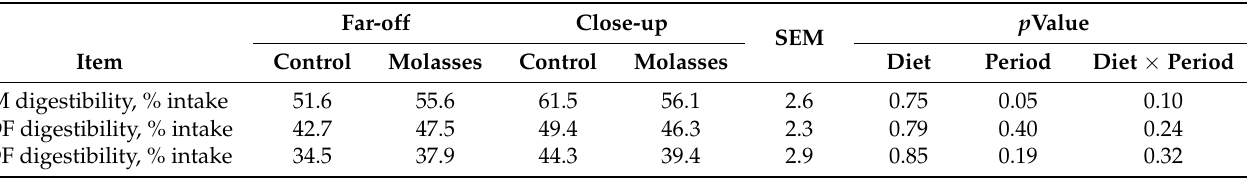
Table 10. Diet organic matter (OM), neutral detergent fiber (NDF), and acid detergent fiber (ADF) digestibility of far-off and close-up diets by cows fed either control or molasses-containing diets during the dry period (Experiment 2). Far-off